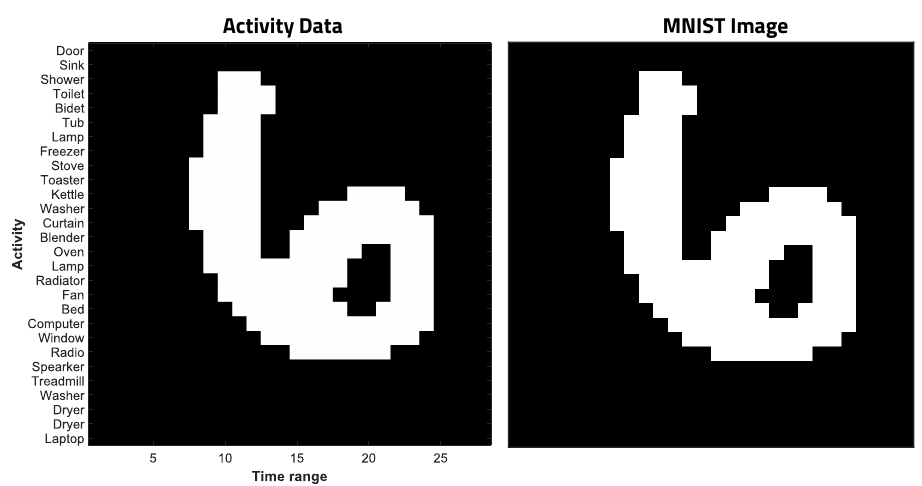
Figure 5. Similarity between activity data and MNIST